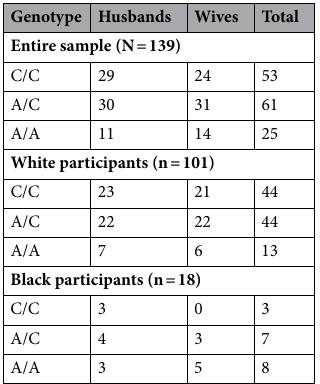
Table 3. Genotype counts for rs3796863. Frequencies for each genotype of CD38 rs3796863 in the total sample, as well as for White and Black participants